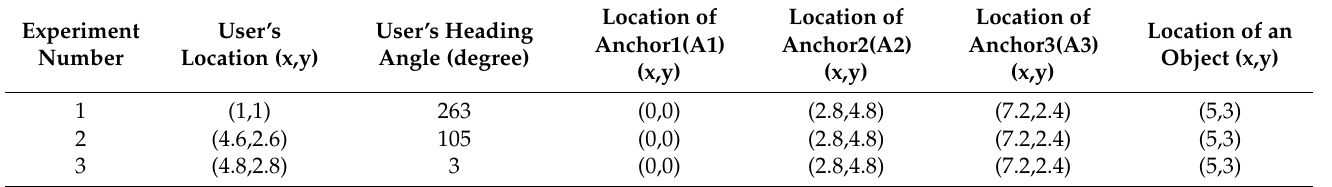
Figure 9. The three anchors of the indoor positioning system’s location (A1, A2, A3). The object location was shown as (Obj1). The user’s path during the first six seconds of Experiment B was also illustrated (starting from points 1 to 3). The final point of the user: (4.8,2.8), heading angle: 3 degrees. Table 3. Experimental condition in experiment B. We evaluated the indoor positioning system’s accuracy in estimating users’ positioning data and the distance from a specific fixed